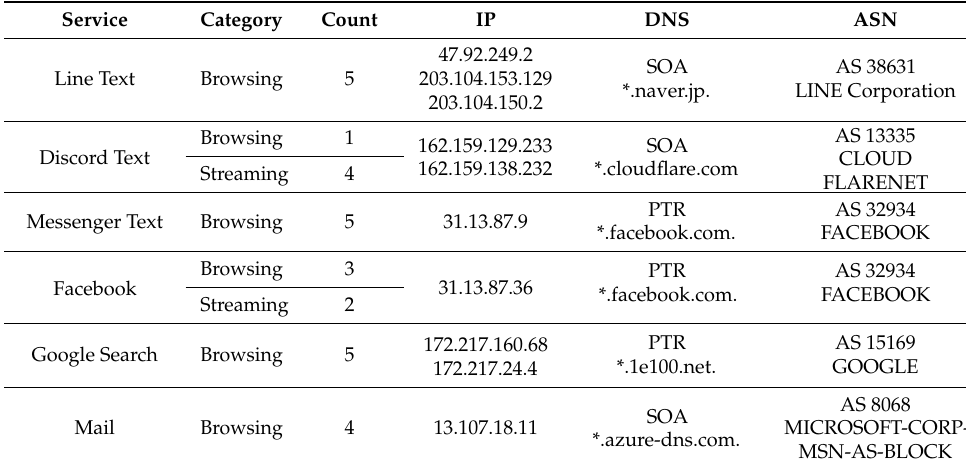
Table 11. Browsing category IP/ASN query results. * stands for